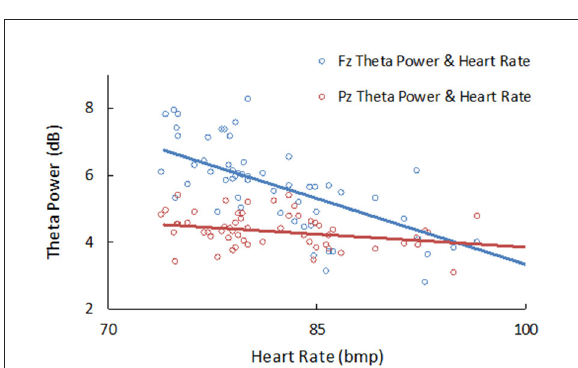
FIGURE4 The significant correlation between heart rate and theta power at Fz ( r = − 0.681, p < 0.001) and Pz ( r = − 0.349, p = 0.008) during LKM